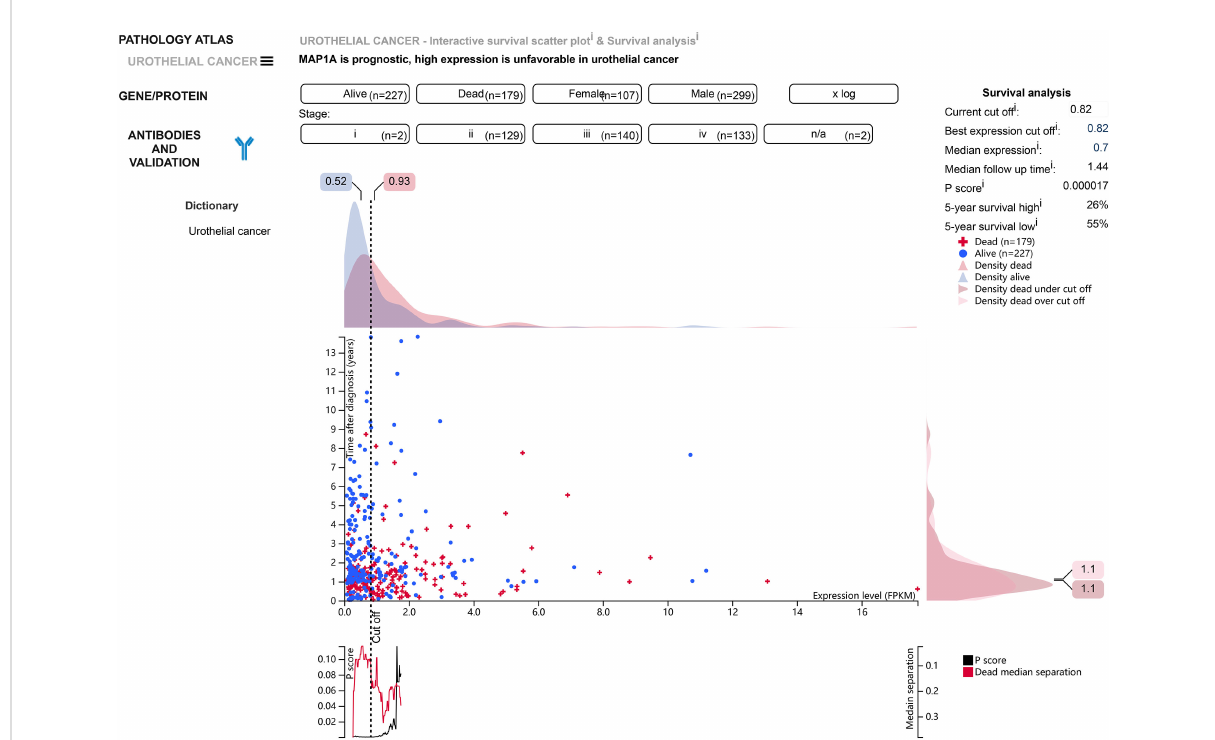
FIGURE 5 According to the HPA database, MAP1A is associated with a poor prognosis in bladder cancer (P < 0.001), and 5-year survival in bladder cancer patients ranges from 26% to